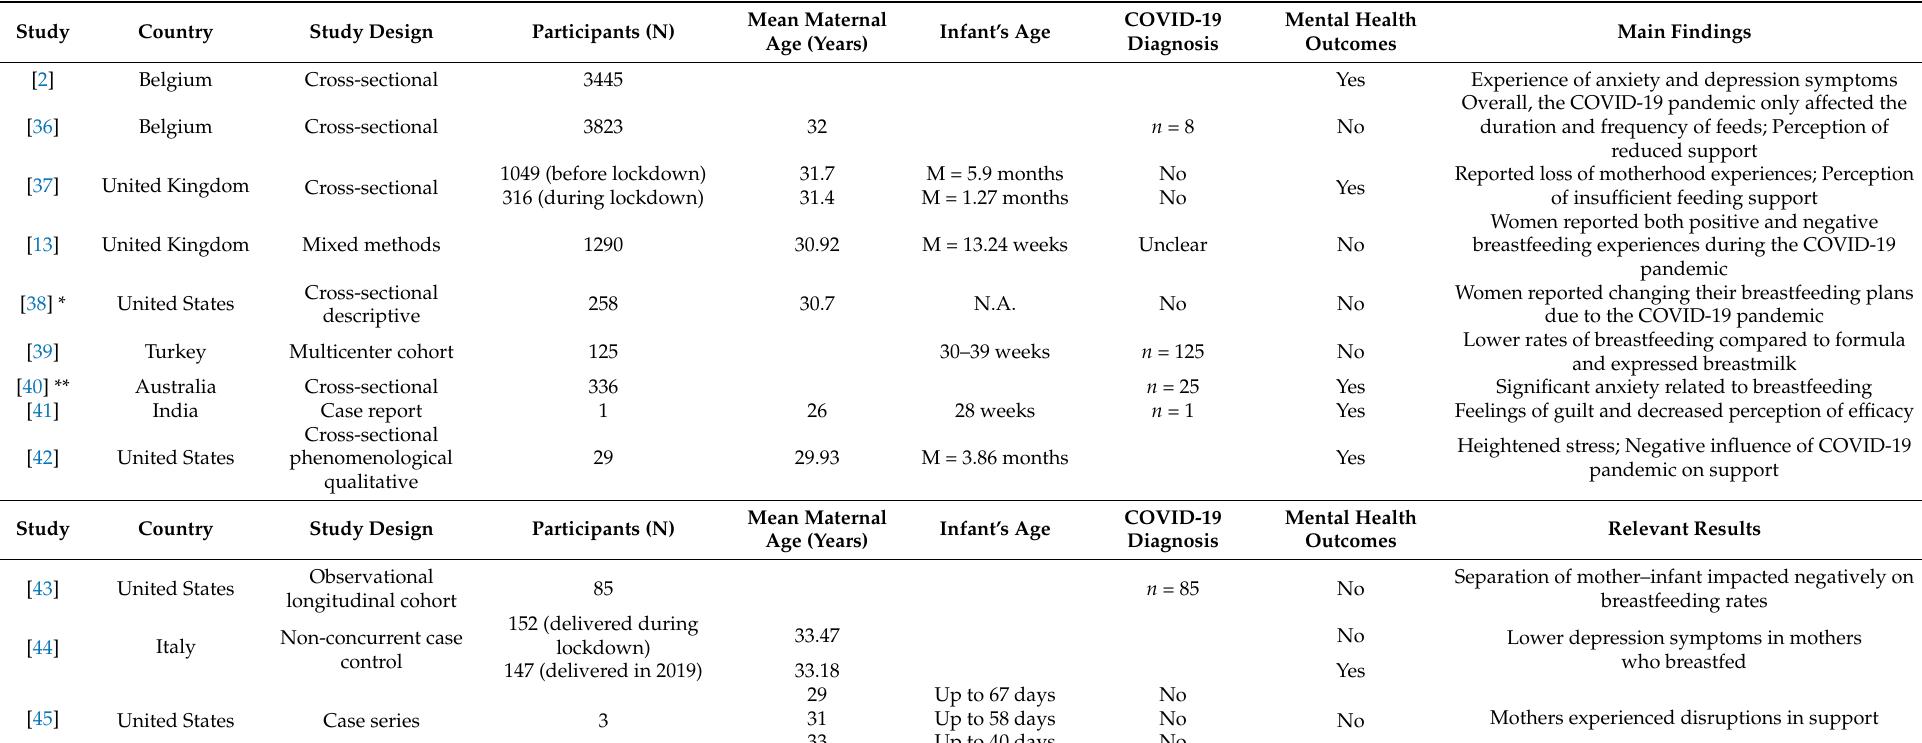
Table 1. Detailed information of the included